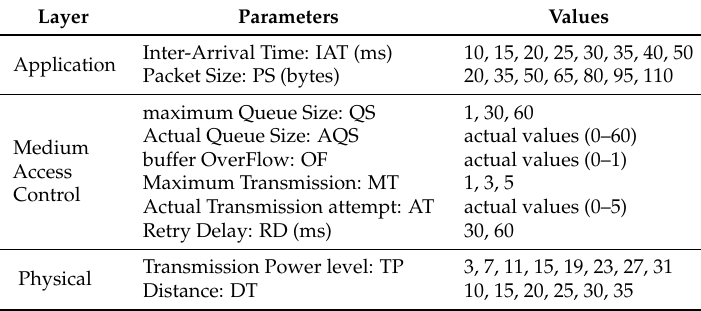
Table 3. Stack parameter